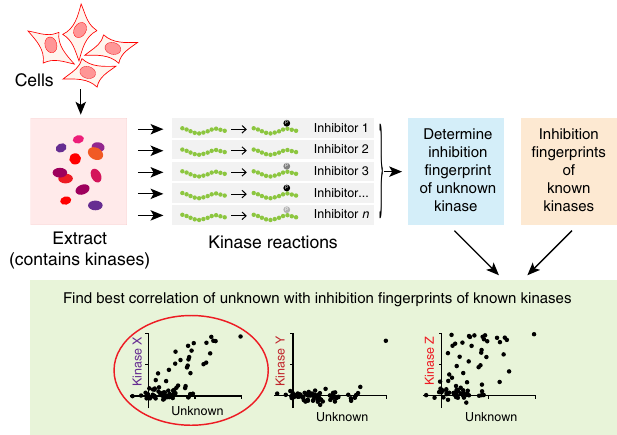
Fig. 1 Outline of the KiPIK method. In KiPIK, cell extracts (red box) are used as the source of all relevant kinases. Multiple kinase reactions are then carried out using an exogenous substrate of interest, each in the presence of single well-characterized kinase inhibitor (gray boxes) to produce an inhibition fi ngerprint for the unknown kinase (blue box). Comparison of this fi ngerprint with the known fi ngerprints of multiple kinases (orange box) using Pearson correlation coef fi cients (green box) allows candidate kinases to be